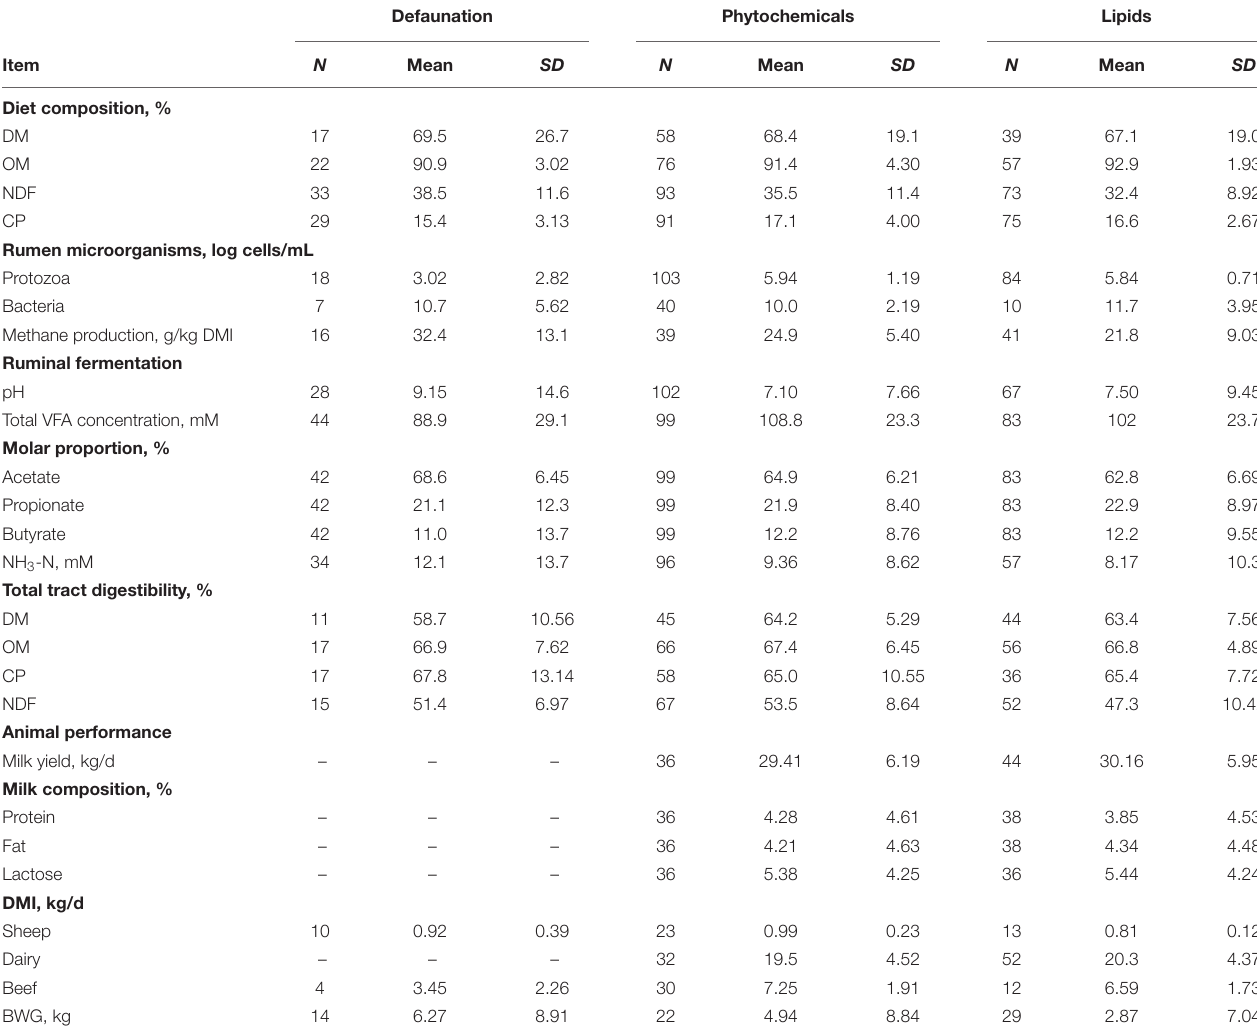
TABLE 1 | Statistical description of the diet and animal characteristics in the data set used for the meta-analysis. Defaunation Phytochemicals